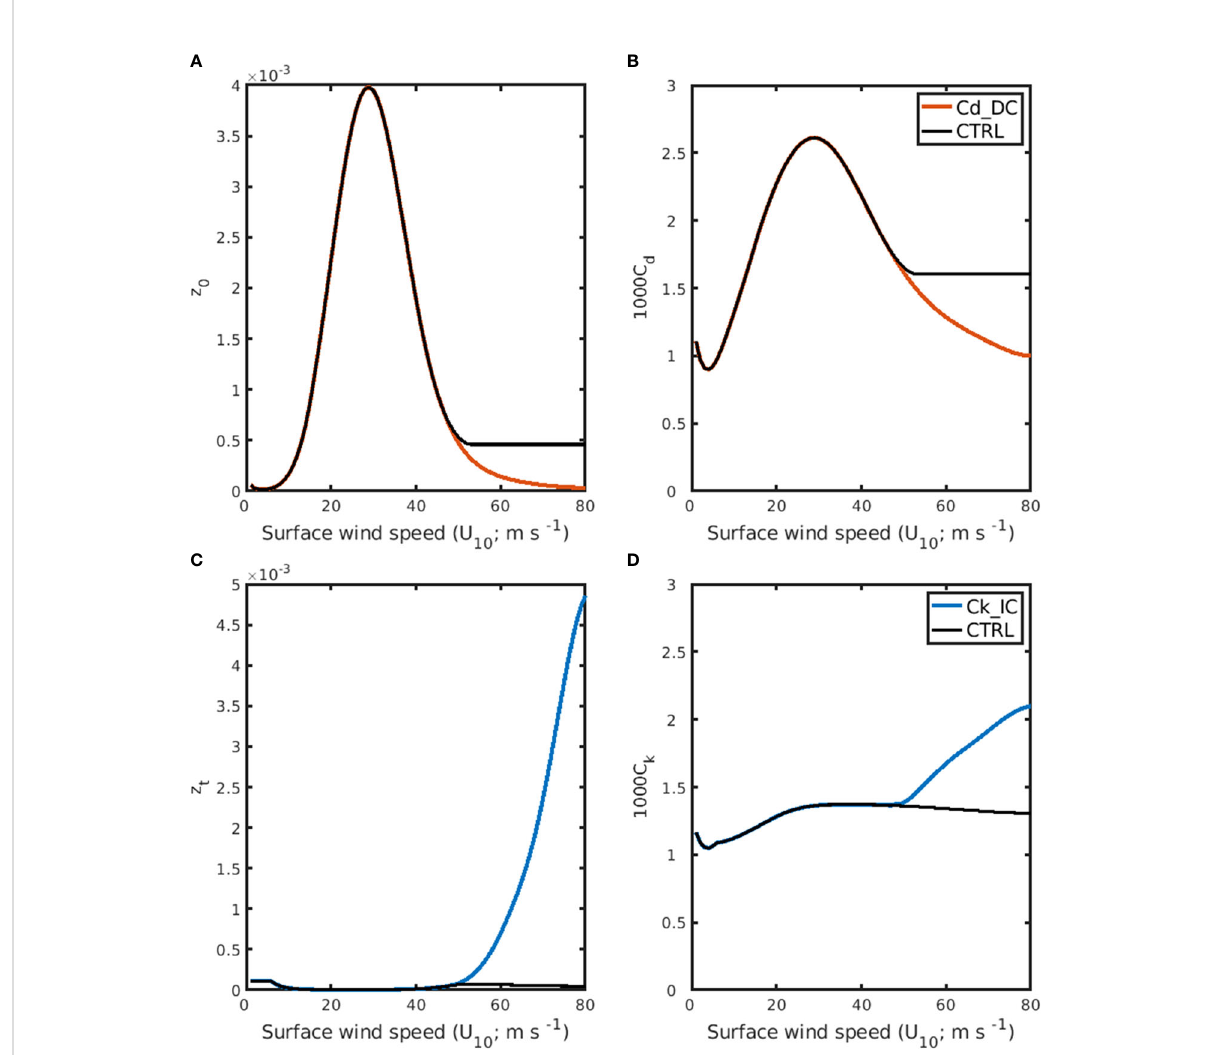
FIGURE 3 Parameterization of (A) roughness lengths for momentum z o , (B) drag coef fi cient C d , (C) roughness lengths for heat and humidity, and (D) heat exchange coef fi cient C k as a function of 10-m wind speed, as used in the CTRL, Cd_DC and Ck_IC experiments (CTRL, black curve; Cd_DC, red curve; Ck_IC, blue